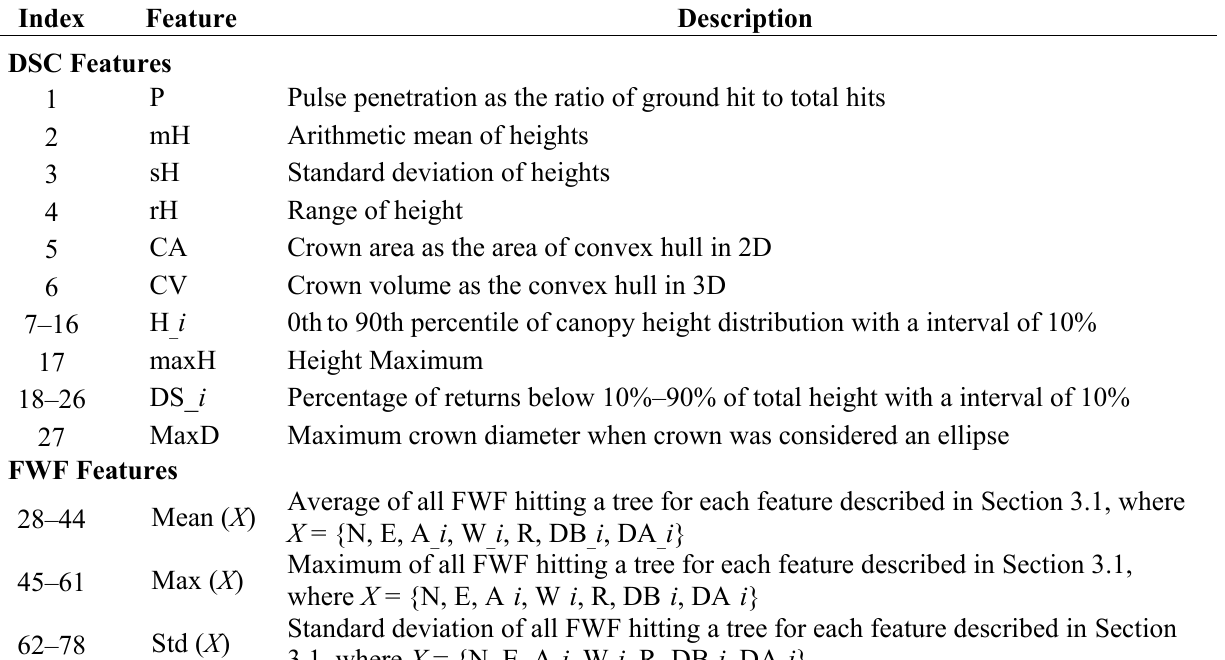
Table 2. DSC (Discrete) features calculated from all normalized vegetation points of DSC data and descriptive statistical values of full-waveform (FWF)